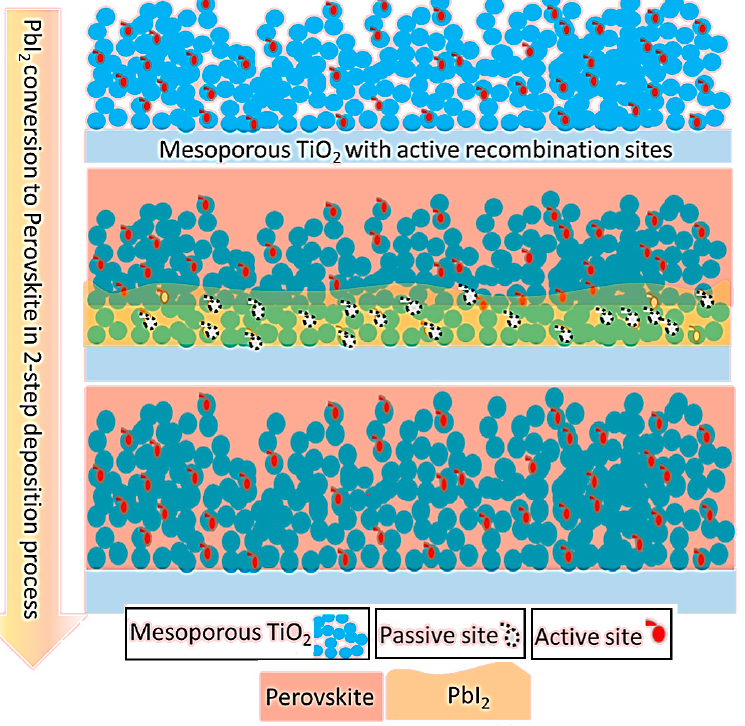
Figure 6. The presence of unreacted PbI 2 passivates the active oxygen defects. Thus, efficient conversion of PbI 2 to the perovskite is not ideal to achieve efficient PSCs.